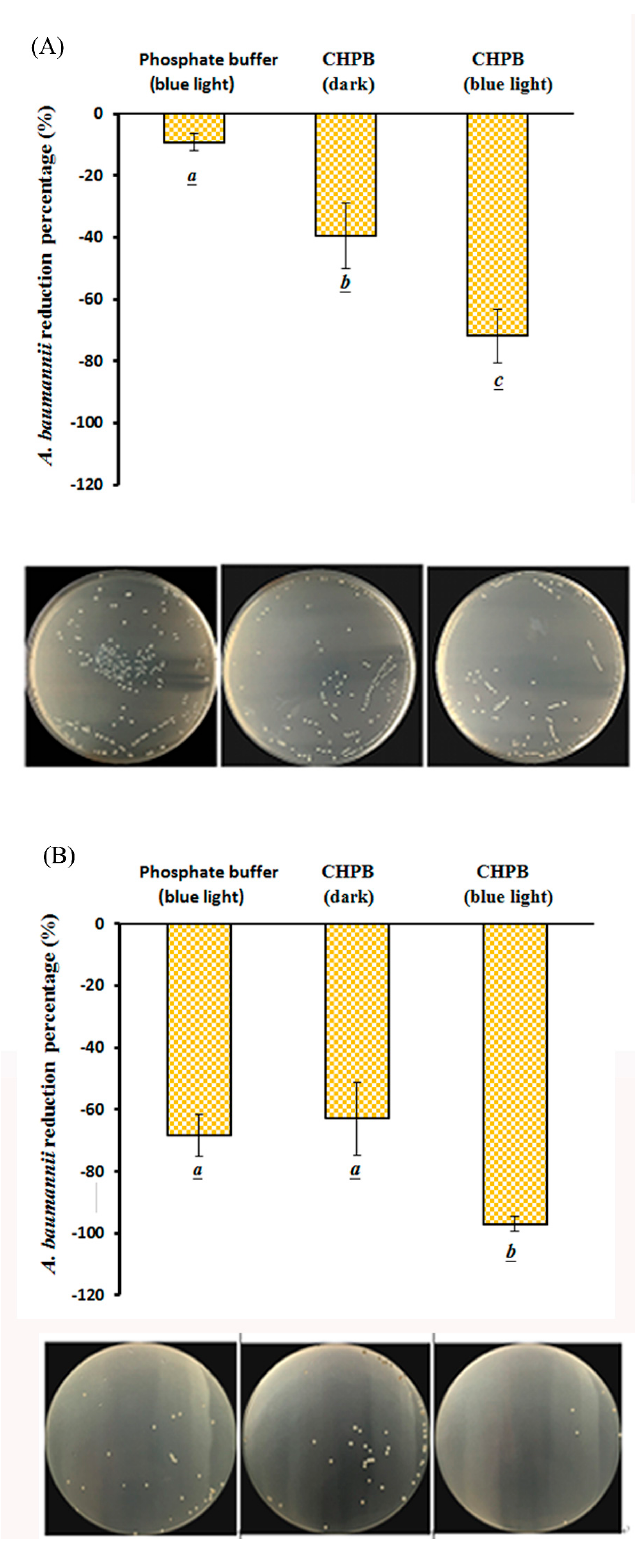
Figure 5. Effects of photochemical treatments on the viability of A. baumannii treated with ( A ) 145 µ g/mL CHPB (pH 7.8) under blue light irradiation at 1.0 mW/cm 2 for 60 min and ( B ) 290 µ g/mL CHPB (pH 7.8) under blue light irradiation at 2.0 mW/cm 2 for 120 min. Data are represented by mean ± SD, where n = 4. Statistical differences ( p < 0.05) between groups are indicated by the different letters below each